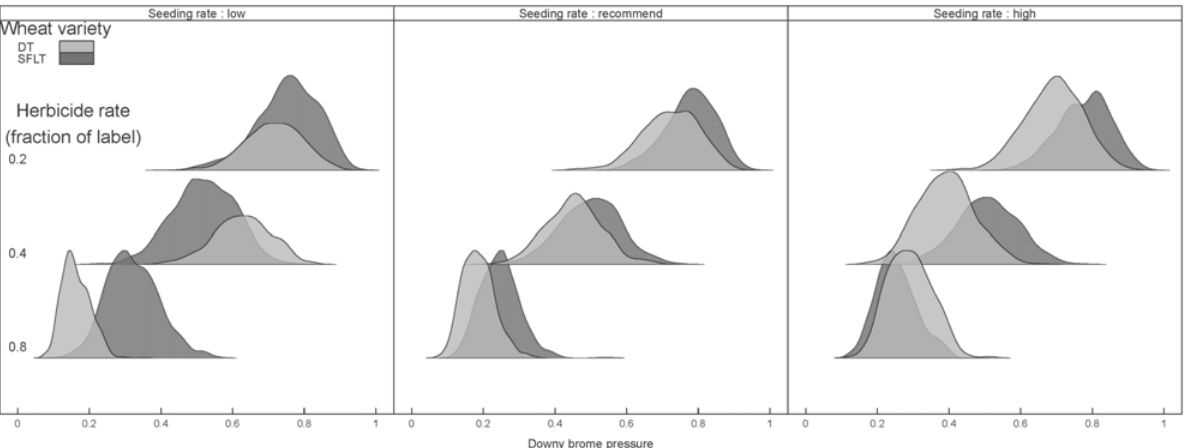
Fig 3. Posterior distributions of Bromus tectorum pressure by wheat variety and seeding rate treatments after three years of 0.2x (top), 0.4x (middle), or 0.8x (bottom) herbicide application rate. Crop variety treatments are drought tolerant spring wheat (DT) and Cephus cinctus tolerant spring wheat